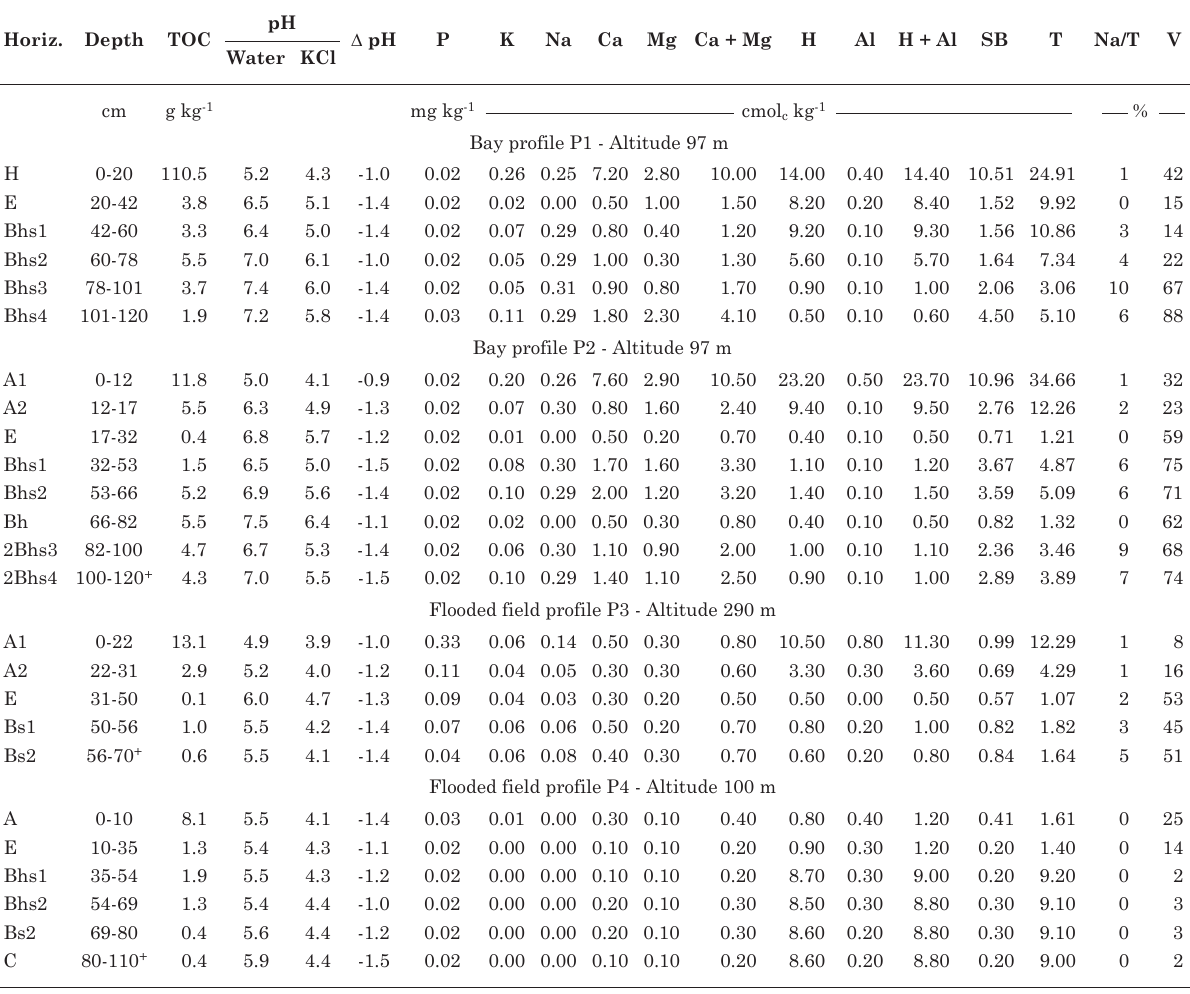
table 3. Chemical properties of soils developed from sediments of the river taquari watershed in the Pantanal of Mato grosso do sul